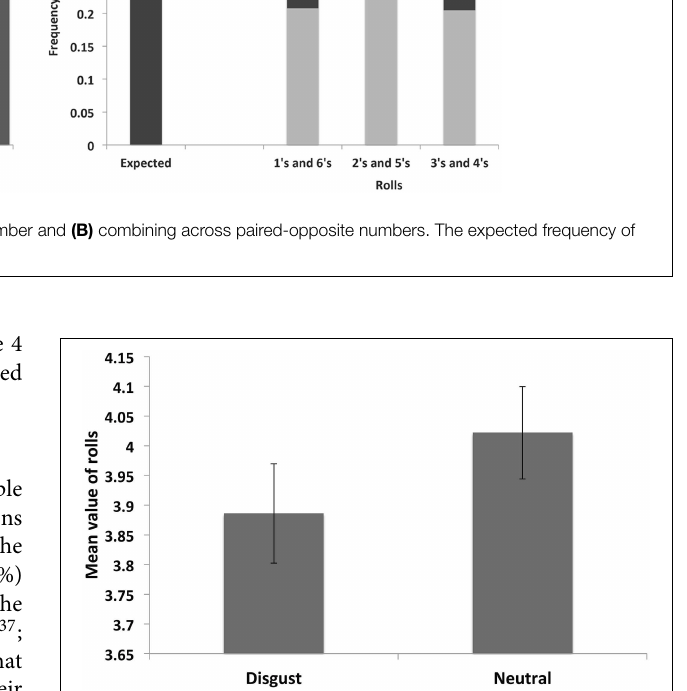
FIGURE 3 | Main effect of disgust presentation. Subjects ( N = 49 ) were slightly less dishonest in the disgust than the neutral condition, but this effect was not